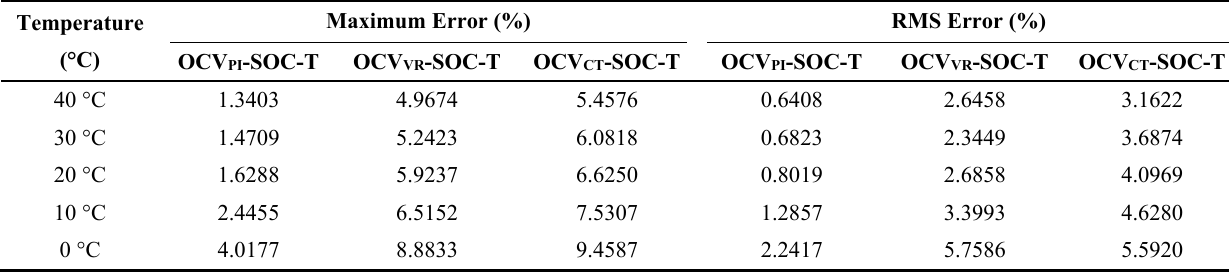
Table 2. List of statistics of SOC estimation errors with different OCV–SOC–T relationship